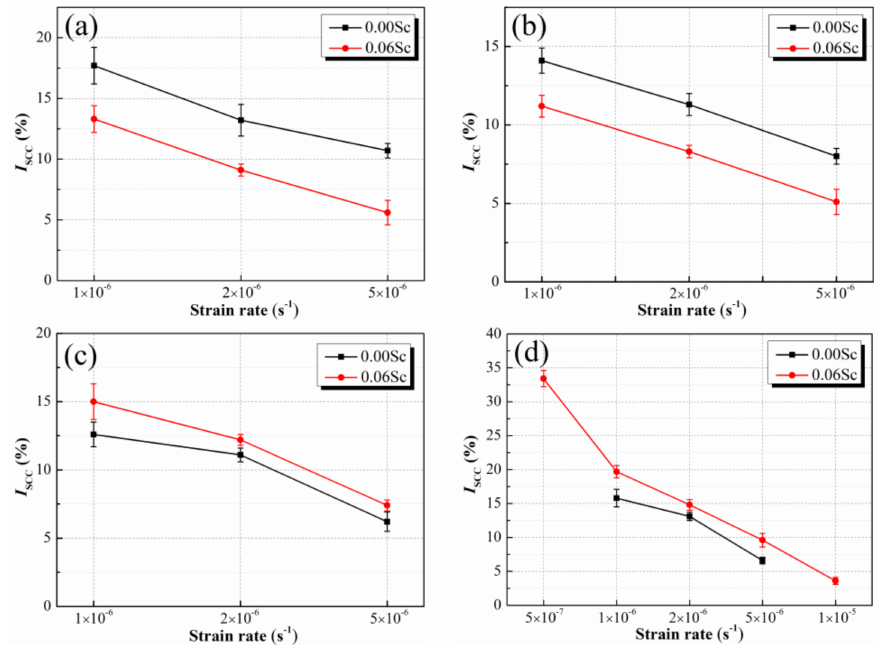
Figure 6. SCC susceptibilities of two aged alloys at different strain rate in acid and alkaline solutions: ( a ) pH 1; ( b ) pH 3; ( c ) pH 10; ( d ) pH 12.